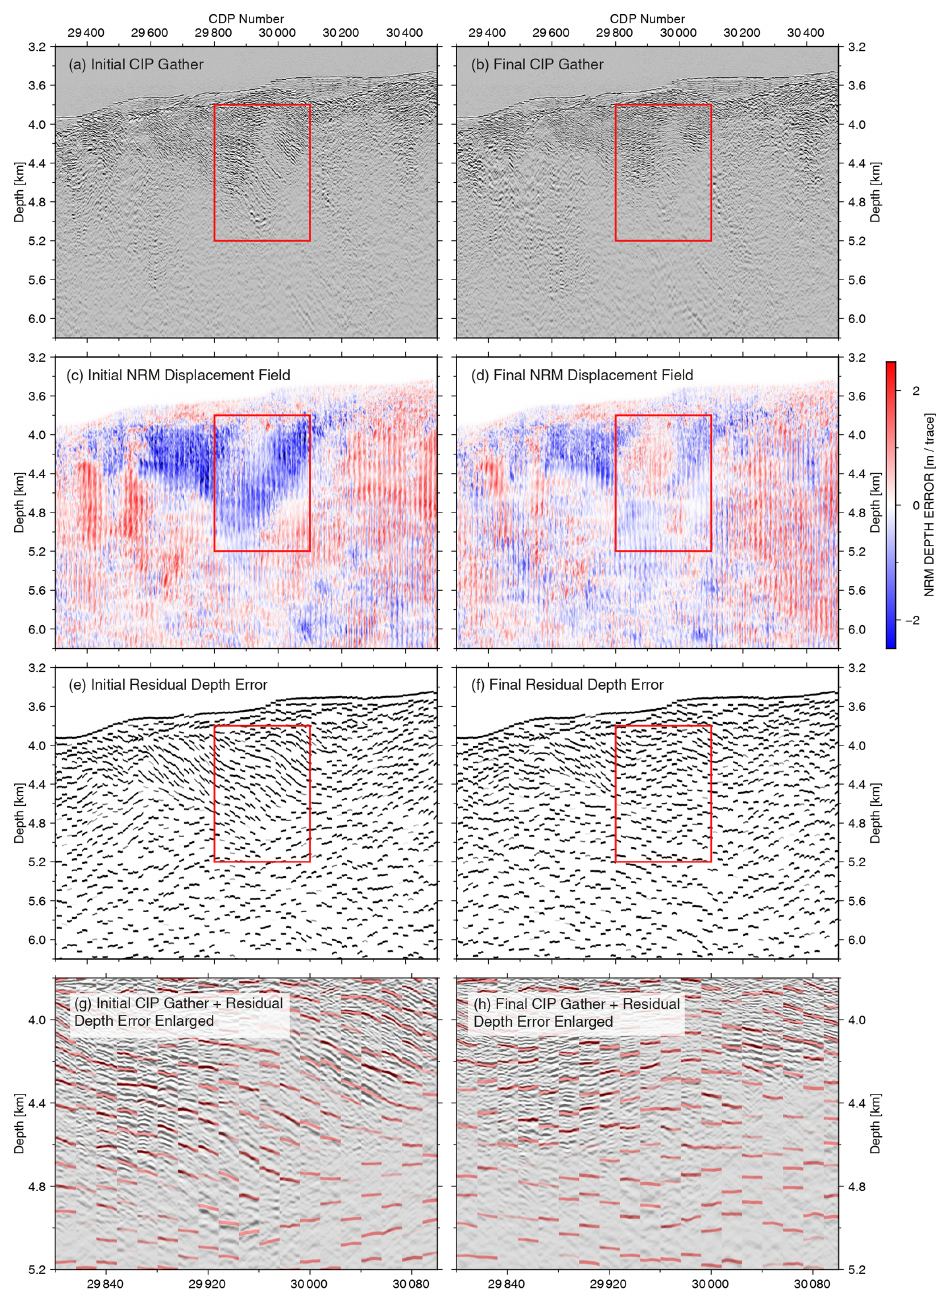
Figure 11. NRM velocity update of Fig. 10 in CIP domain. (a) CIP gathers based on the initial velocity model. (b) CIP gathers based on the final velocity model. (c) Initial NRM depth shifts in the CIP domain. (d) Final NRM depth shift in CIP domain. (e) RMO picks calculated from the initial NRM displacement field. (f) RMO picks calculated from the final NRM displacement field. Note that the distinct area of velocity overestimation in the red rectangle in (c) has been substantially reduced after the tomography (d) . CIP gathers (e) and (f) of the red rectangle from (c) and (d) respectively overlaid by RMO picks. Strong dipping events in the initial CIP gather (g) have mostly been flattened after the final iteration (h)